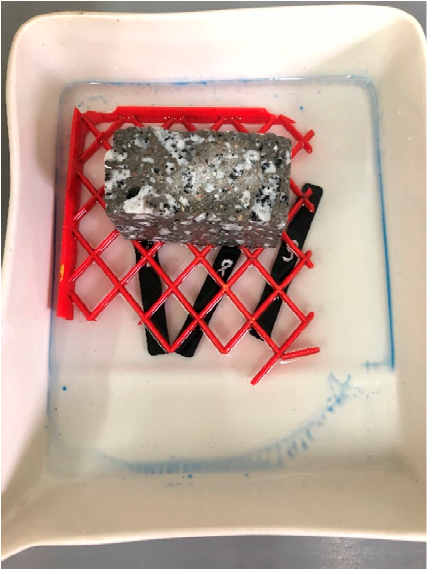
Figure 17. Plastic samples immersed in de-icing agent.